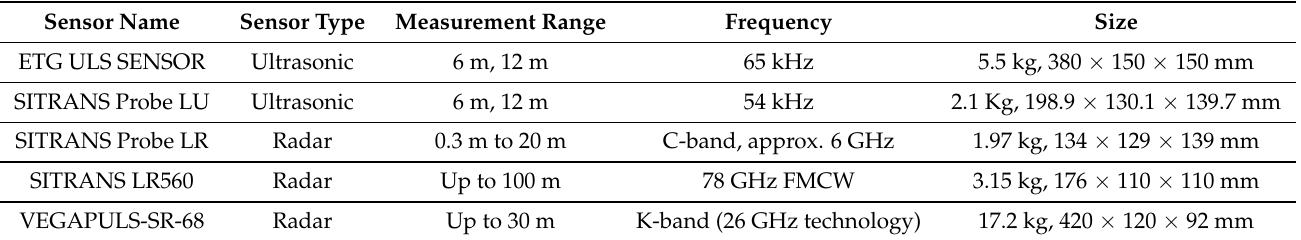
Figure 7. Example of a gauge ultrasonic sensor used to acquire the stages measurements (SITRANS Probe LU, Table 1). Table 1. Sensors used for acquisitions in control